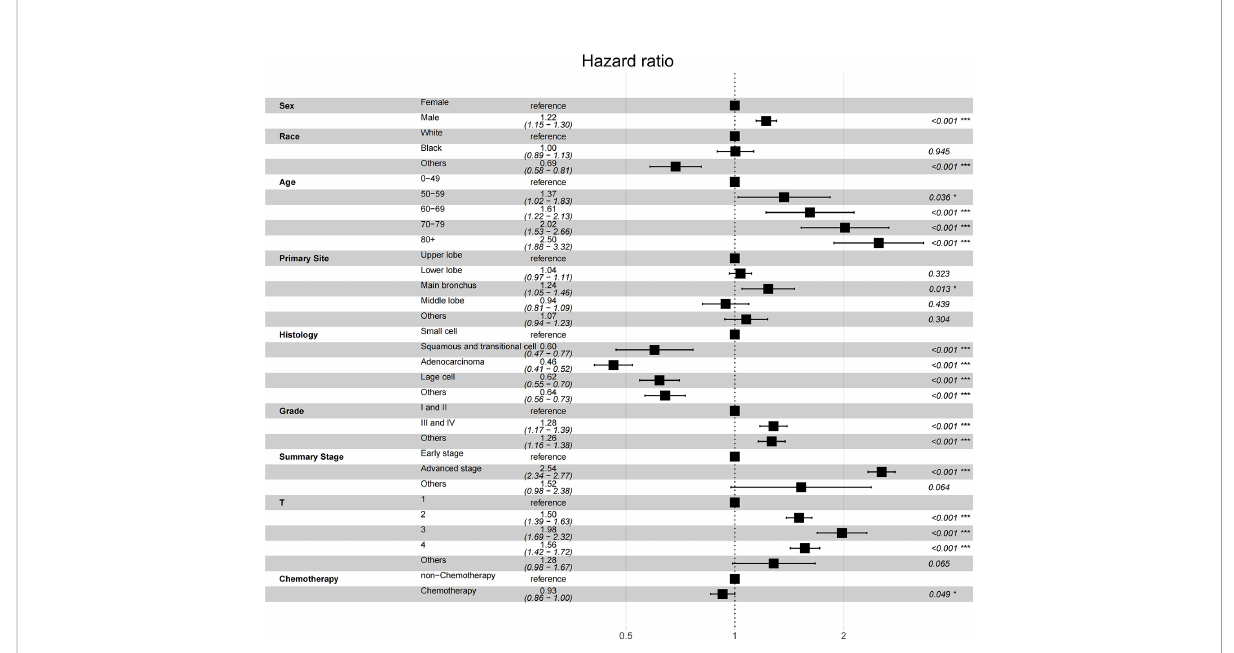
FIGURE 5 Forest plot of association between survival and multivariables in patients with SPLC